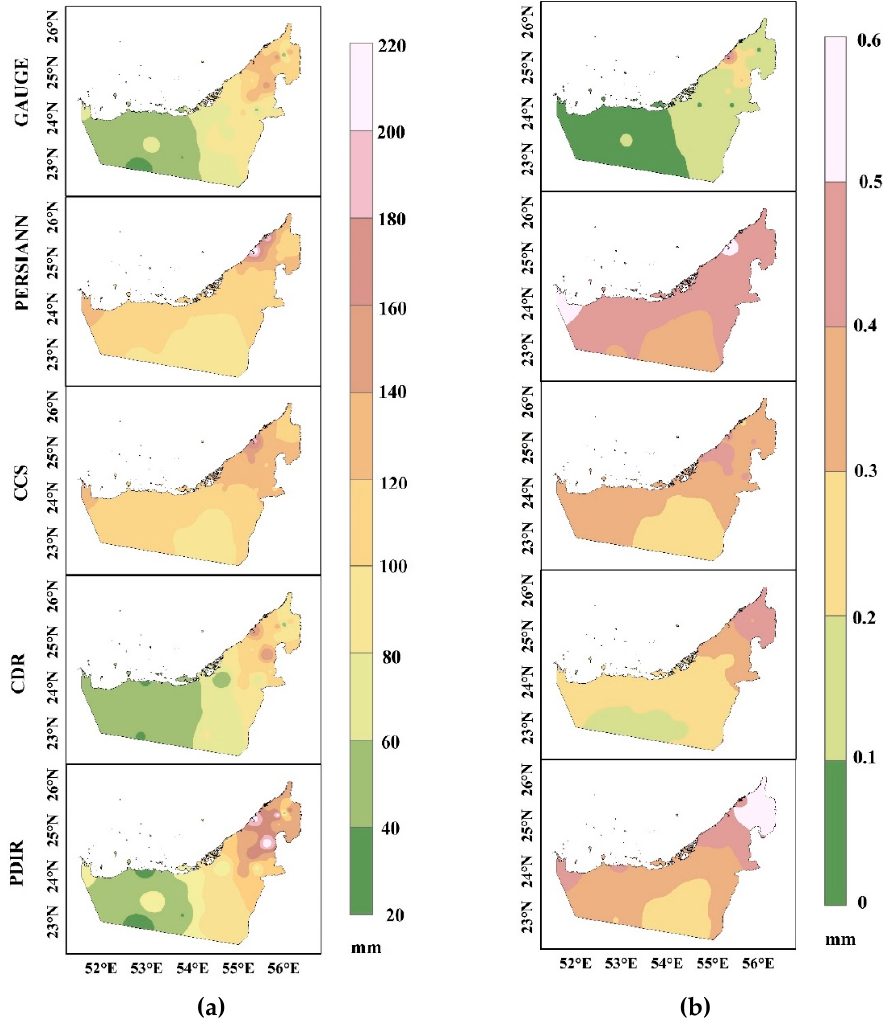
Figure 3. Annual ( a ) and daily ( b ) average rainfall distribution of rain gauge and PERSIANN satellite products across the study region from 2011 to 2020.